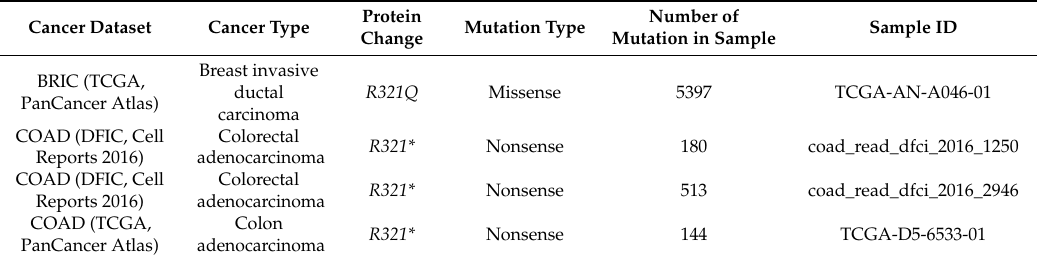
Figure 4. BMP5 genes in different cancer types (PrognoScan database). The statistically significant hazard ratio for various kinds of cancers was identified from our analyses in Supplementary Table S2 and expressed as the forest plot. The study of survival curve was identified as the threshold of cox p -value < 0.05. Table 1. Data analysis of the BMP5 gene in three di ff erent cancer types derived from cBioPortal for Cancer